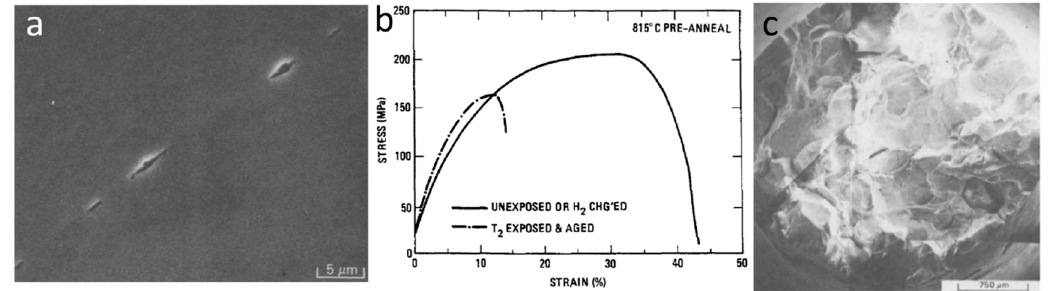
Figure 19. ( a ) Intergranular cavities along GB in Cu after T 2 exposure; ( b ) tensile behavior of unexposed and T 2 charged and aged Cu; and ( c ) intergranular fracture surface morphology of Cu after tritium exposure treatment. Reprinted with permission from [140]; Copyright 1986 Elsevier.